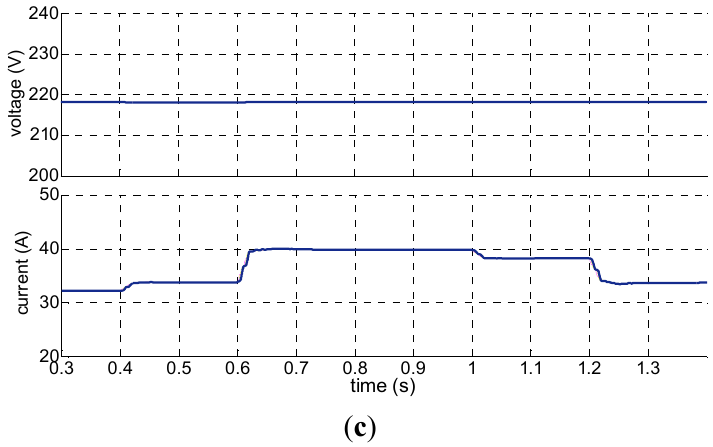
Figure 11. The effect of PQ control on a storage battery and wind turbine: ( a ) Active power of the storage battery and wind turbine; ( b ) Reactive power of the storage battery and wind turbine; ( c ) Effective values of phase voltage and line current output from the storage